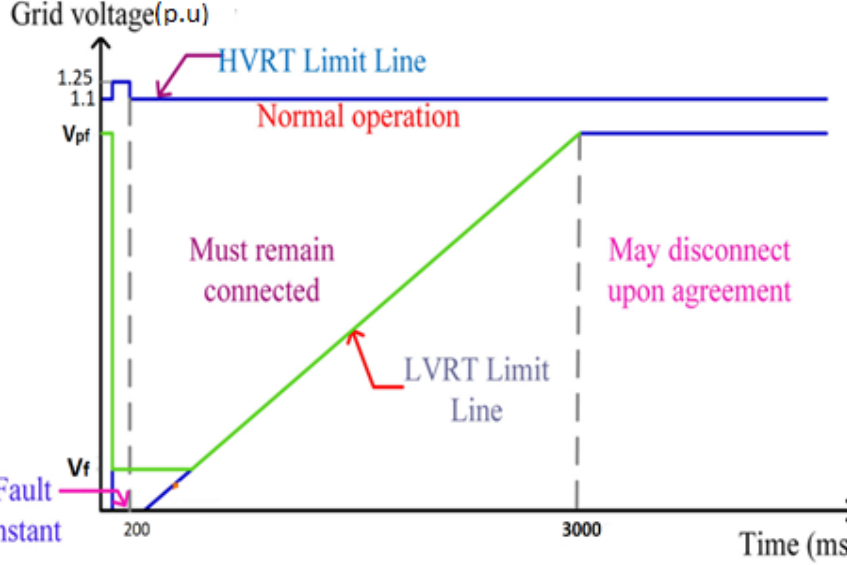
Figure 1. Fault ride through characteristics.